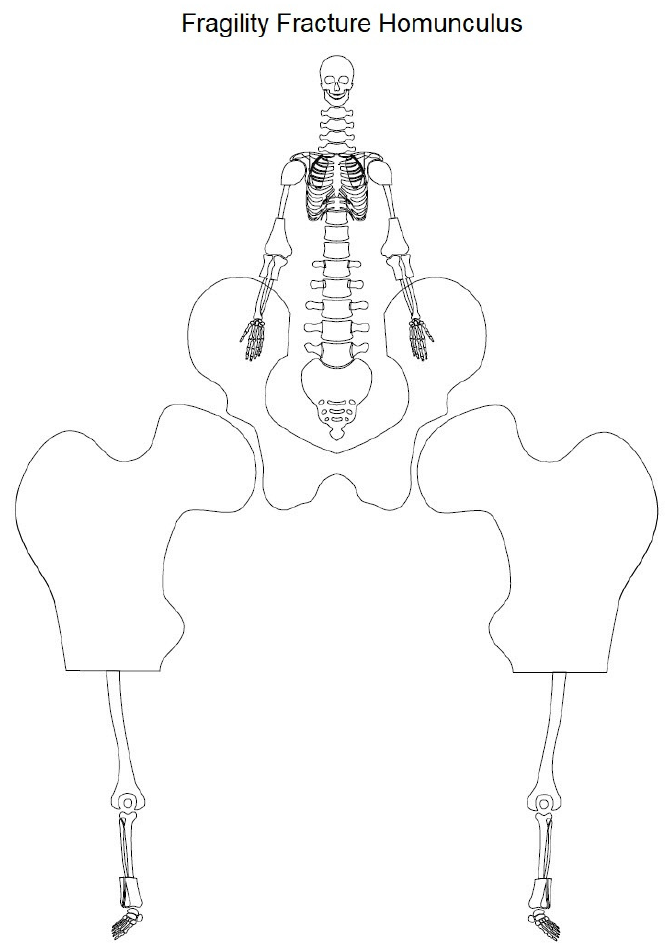
Figure 8. Schematic drawing illustrating the “fragility fracture homunculus” indicating different focusses of therapeutic studies represented with disproportionate sizes of the anatomical sites being reported. The anatomical sites were enlarged by the following equalization: Focus ( n ) + 1. Hip joint ( n = 14), pelvis ( n = 5), spine ( n = 3), ankle ( n = 3), distal femur ( n = 2), elbow ( n = 2), shoulder ( n =